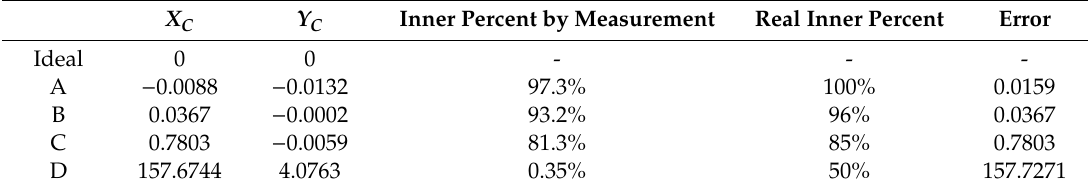
Table 2. The estimated center by improved M-estimation fitting